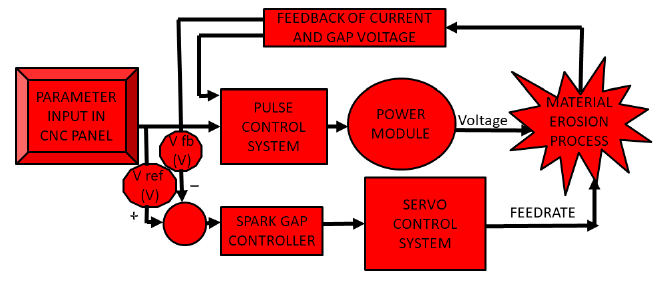
Figure 2. Line diagram for EDM control system [84].